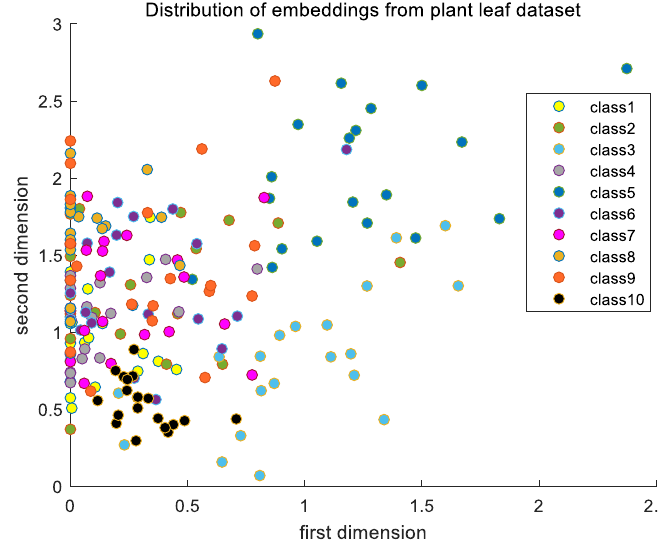
Figure 15. The distribution of embeddings from the old leaf task.